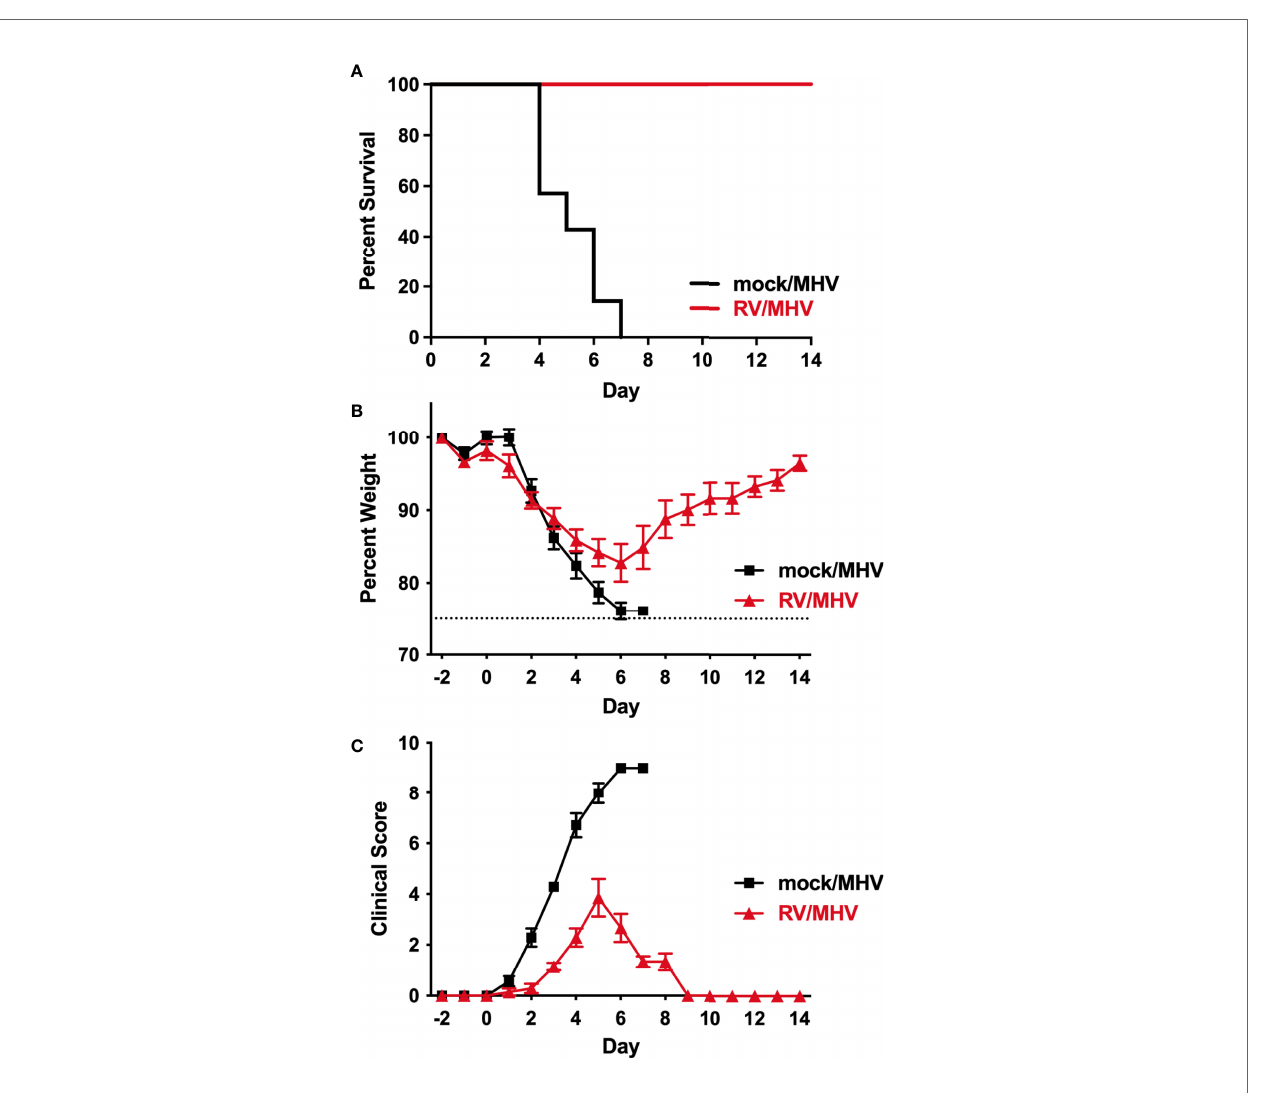
FIGURE 1 | Priming with RV reduces morbidity and prevents mortality upon MHV-1 infection. Mice (n=7 per group) were inoculated intranasally with RV (7.6x10 6 TCID 50 ) or saline (mock) on day -2, and MHV-1 (2x10 5 PFU) on day 0. Mice were monitored daily for (A) mortality ( p =0.0004) (B) weight loss ( p >0.05) and (C) clinical scores (days 2-7: p